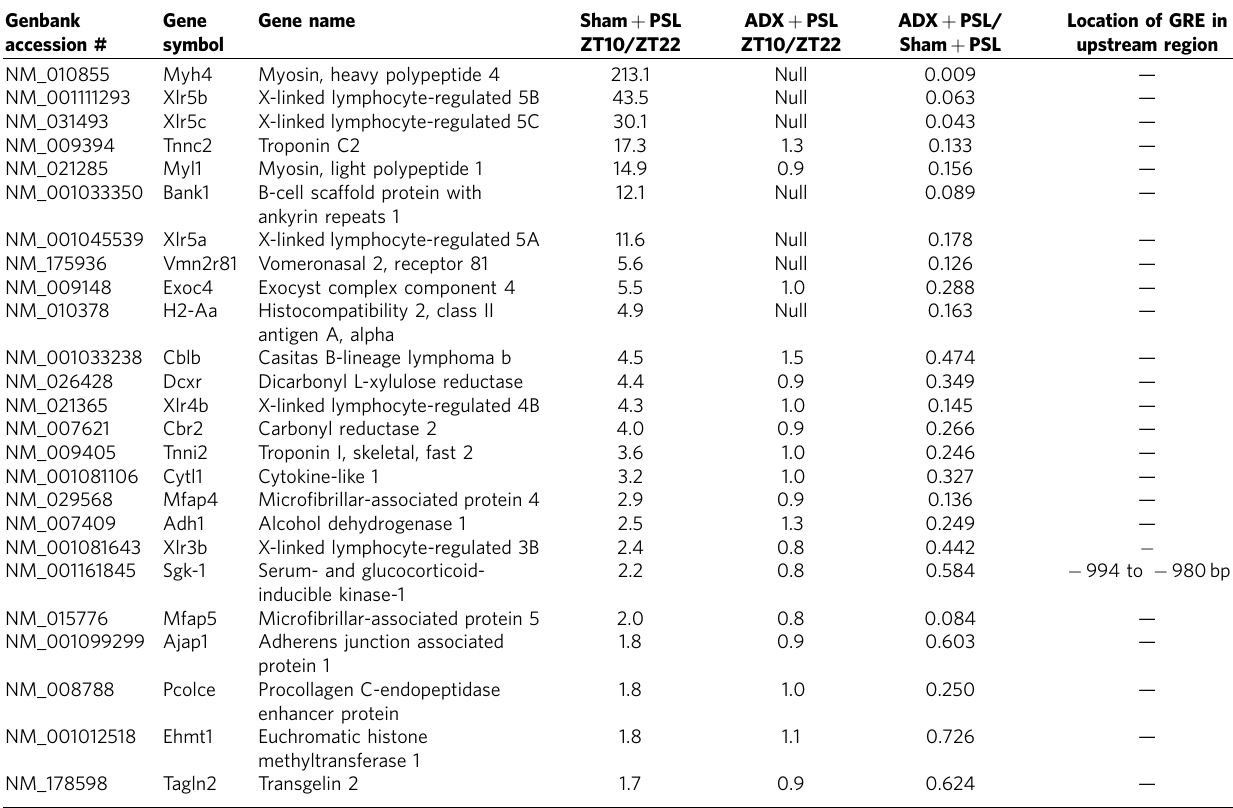
Table 1 | Candidates for glucocorticoid-regulated genes in spinal cords of mice. Genbank accession